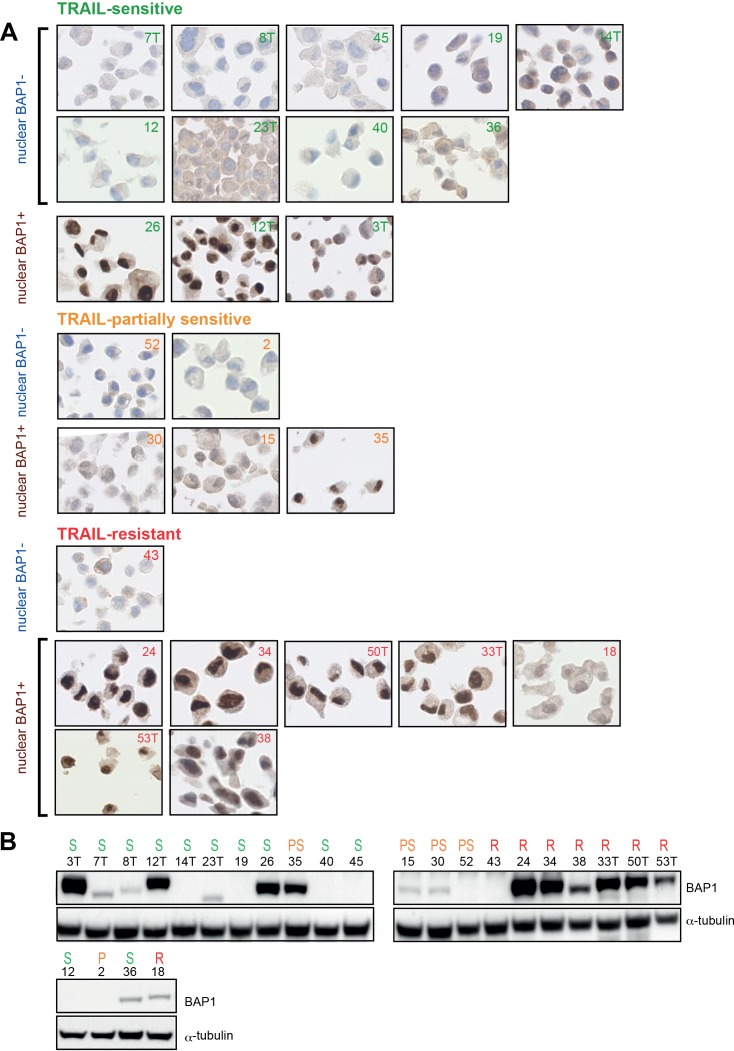
BAP1 expression in early passage MM cultures.(A) Immunohistochemical analysis and (B) immunoblot. Cultures are grouped by sensitivity to rTRAIL.